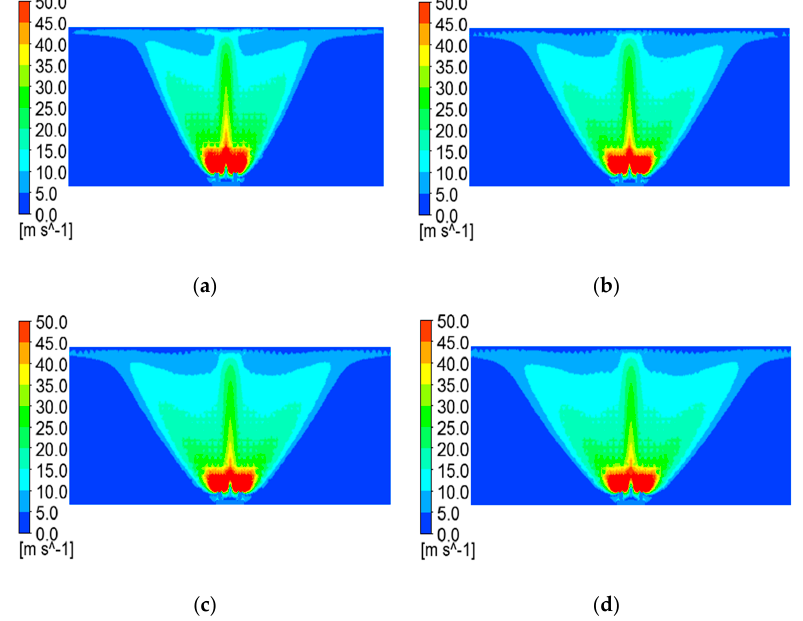
Figure 8. Velocity contours at section z = 0 for different θ values when L = 30 mm: ( a ) θ = 0°; ( b ) θ = 5°; ( c ) θ = 10°; ( d ) θ = 15°.